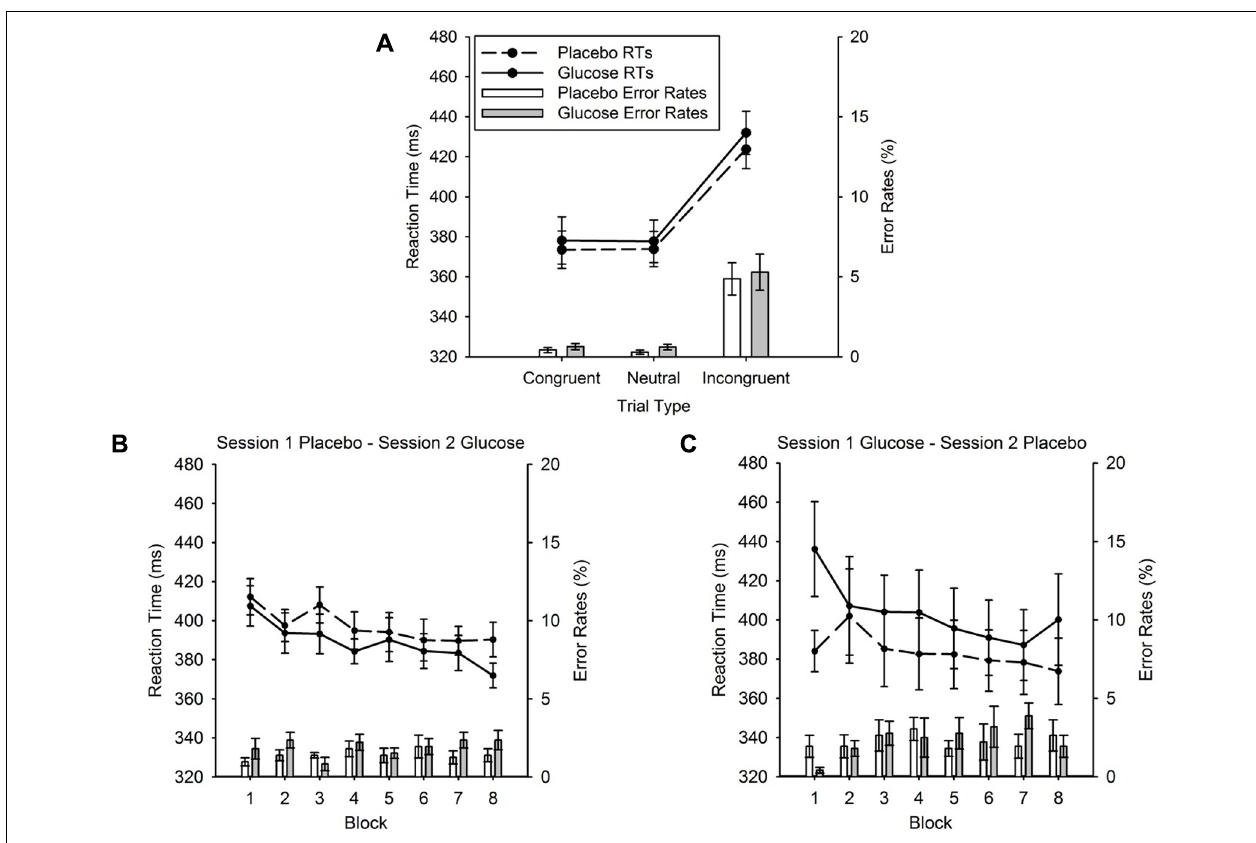
bars) and placebo (dashed lines, white bars) and for each block separately. (C) Session effects in the task, session 1 – glucose, session 2 – placebo. Mean reaction times (lines) and error rates (bars) for glucose (solid lines; gray bars) and placebo (dashed lines, white bars) and for each block separately. Error bars represent the standard error of the